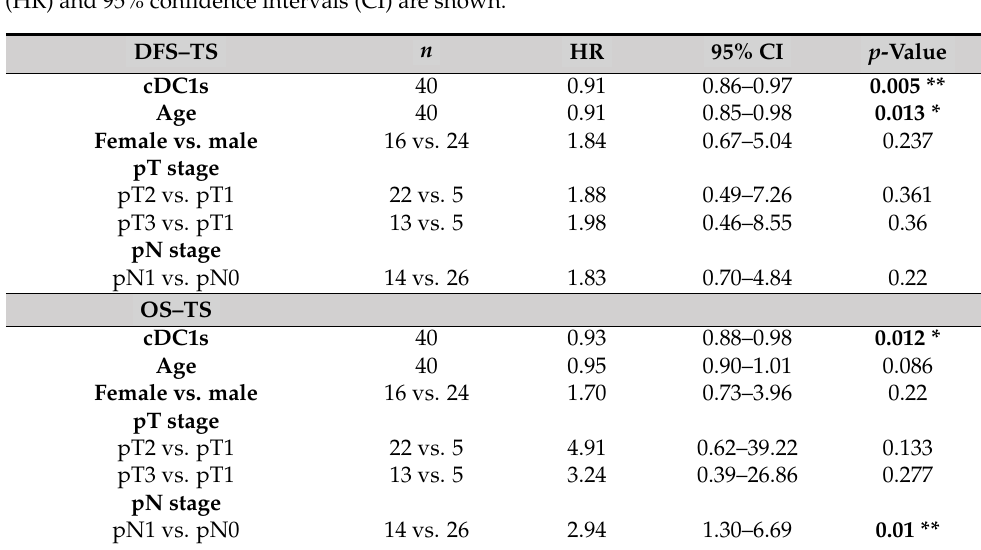
Table 3. Higher frequencies of tumor stroma (TS)-infiltrating conventional dendritic cells type 1 (cDC1s) are correlated with better disease-free survival (DFS) and overall survival (OS). Hazard ratio (HR) and 95% confidence intervals (CI) are